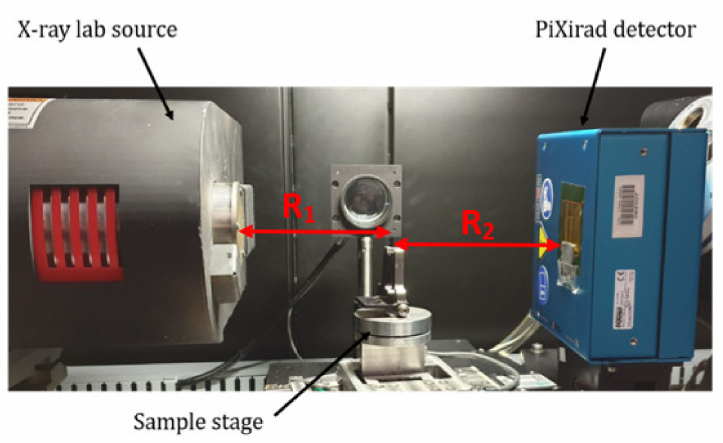
Figure 6. The experimental set-up consisting of the X-ray source, sample stage, and the PiXirad